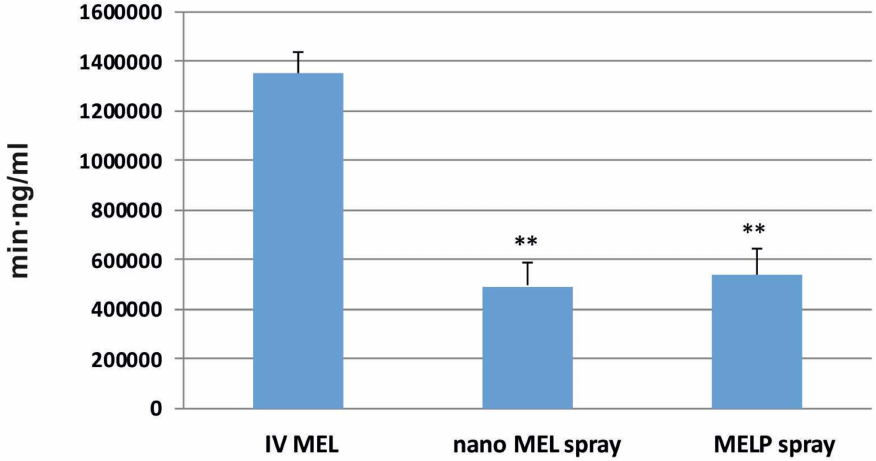
Figure 5. AUC values in the blood plasma of IV MEL and sprays contain nano MEL and